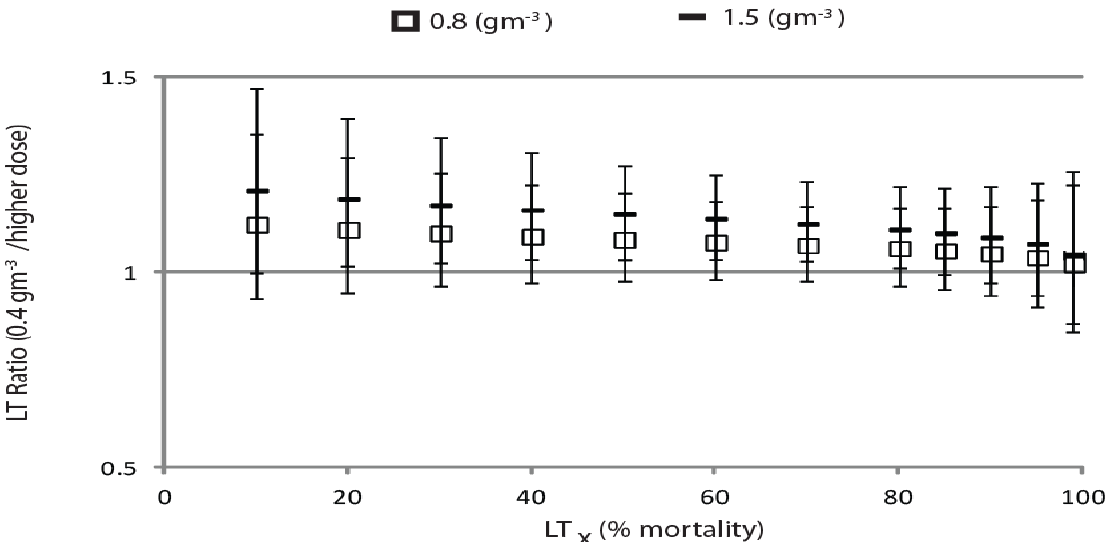
Figure 2. Lethal time ratios (LTRs) associated with steady-state headspace concentrations, [PH 3 ] ss , of 0.4 (250), 0.8 (500), and 1.5 gm −3 (1000 ppmv (µL L −1 )) were calculated ± 95% confidence intervals across the treatment durations projected to cause 10 to 99% mortality in the treated population of adult bean thrips at air temperature 4.9 ± 0.3 °C ( x ± 2 s ). LTRs respective to durations predicted to yield >85% mortality all overlapped a value of 1 (unity), indicating that maintaining a [PH 3 ] ss , of 0.4 g m −3 (250 ppmv (µL L −1 )) was no more efficacious than maintaining [PH3] ss at 0.8 (500) or 1.5 g m −3 (1000 ppmv (µL L −1 )).